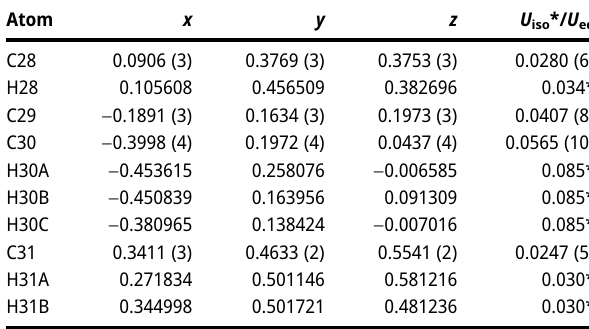
stirred for 5 min. Triethyl orthoformate (30 mL) was subse- quently addedfollowedby the dropwise addition of anhydrous HCl (4.0 M in dioxane, 10.0 mL). The reaction was stirred for 5 h at 70 ° C and concentrated under vacuum. The residue was triturated with ethyl acetate and water until a solid separated. The solid was isolated by fi ltration and washed with cold ethyl acetate to a ff ord the pure desired dimethyl 4,4 ′ -((4 R , 5 R )-